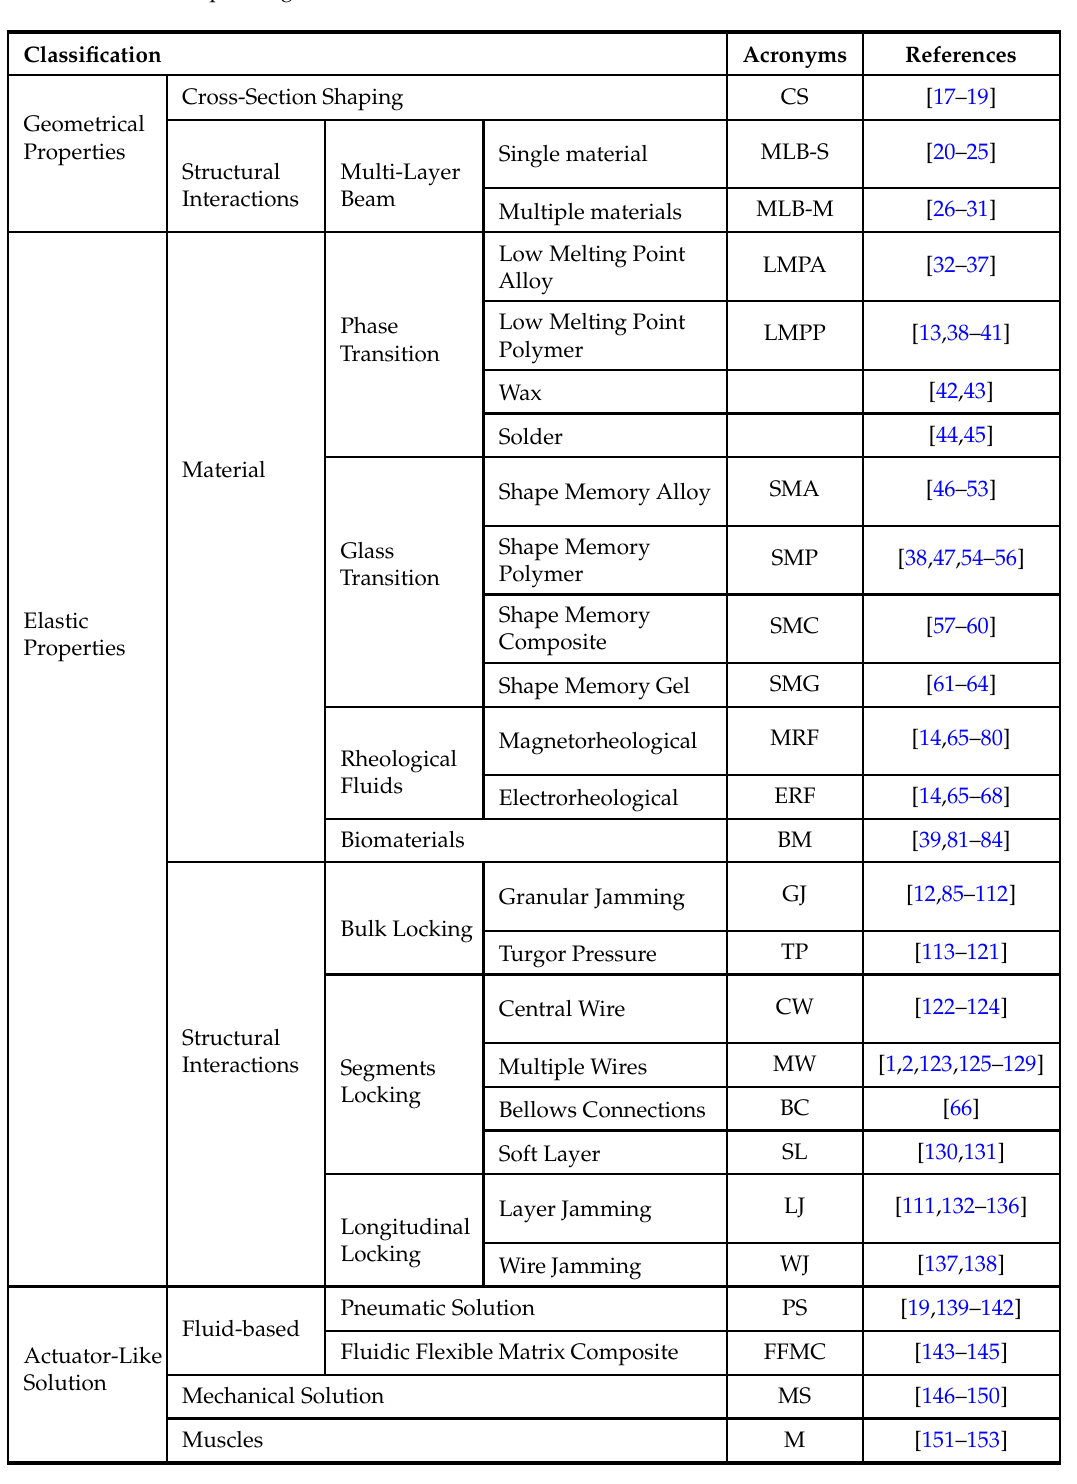
Table 1. Classification of controllable stiffness mechanisms and solutions. The first two families are based on intrinsic properties change (geometrical and elastic properties). The third family counts the active solutions operating as